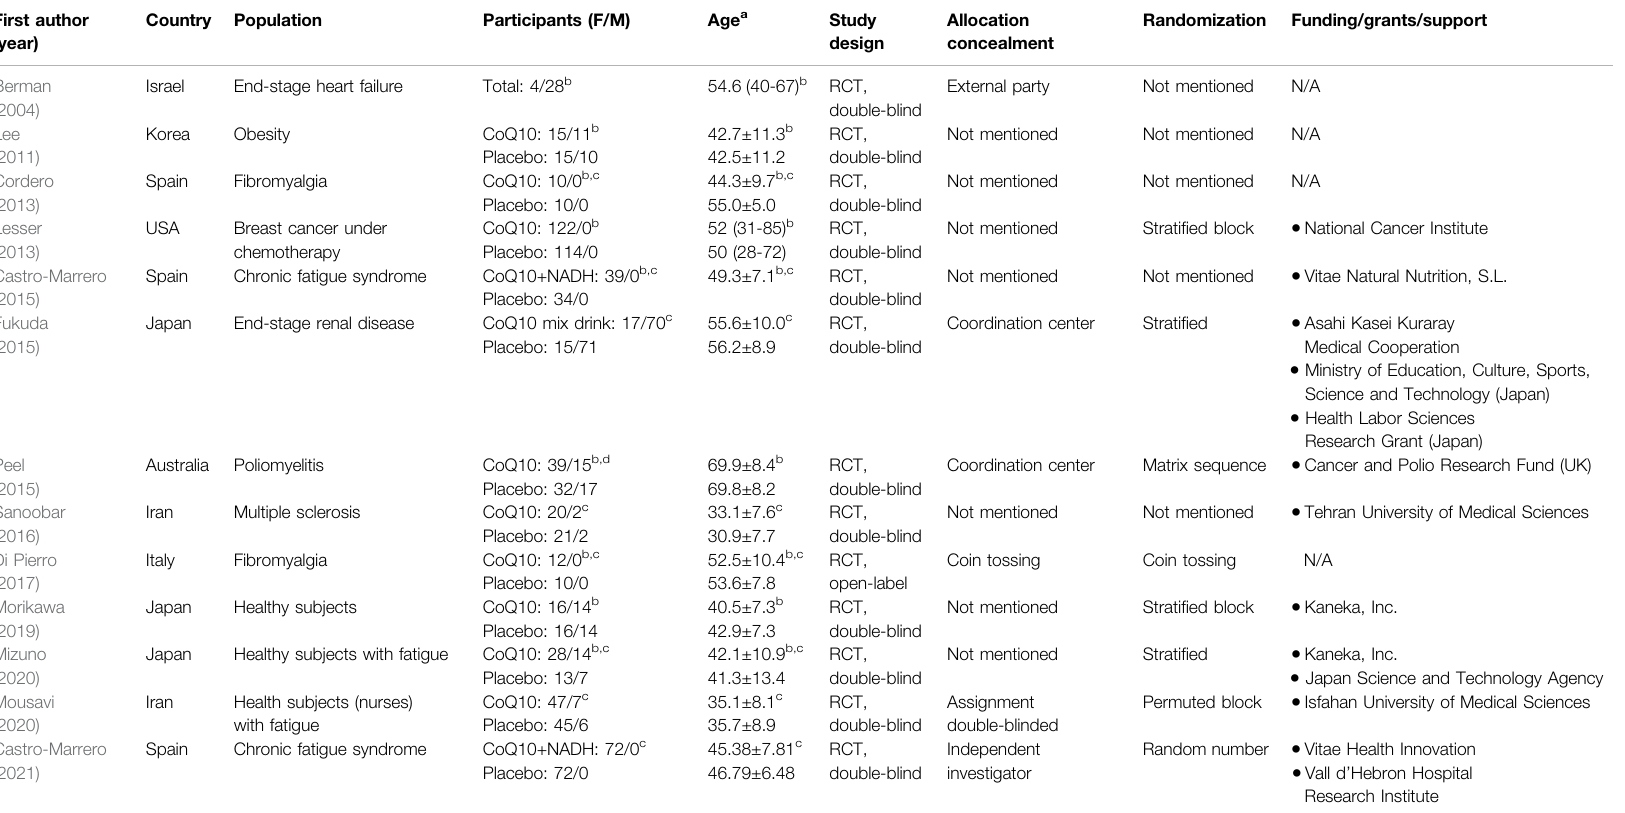
TABLE 1 | Summary of the retrieved trials investigating the effect of CoQ10 on reducing fatigue in the enrolled